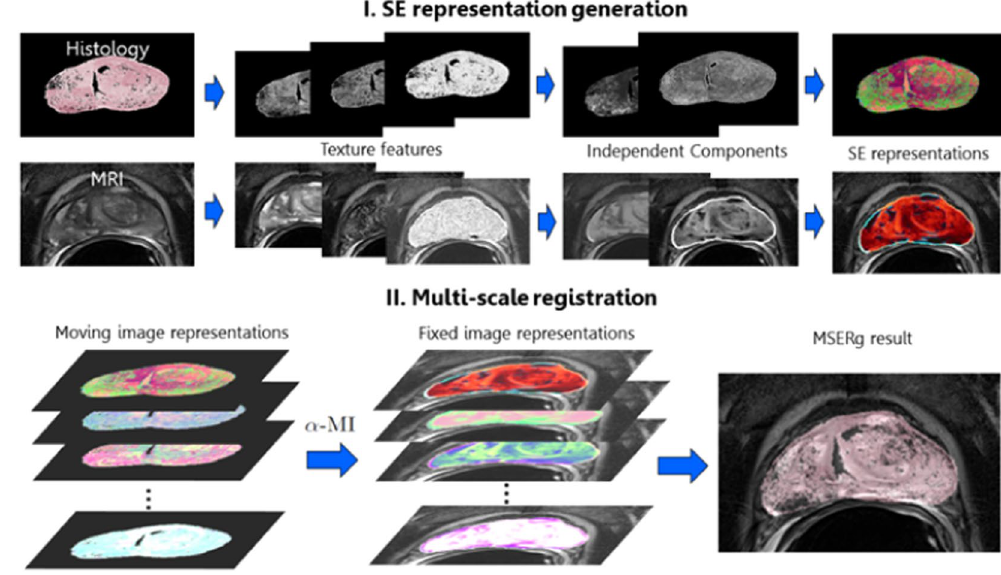
Figure 2. MSERg comprises 2 main modules: Firstly a SE representation is constructed at each scale. (1) Texture feature extraction is performed at each length scale within both the fixed and moving images. (2) ICA is then performed at each texture feature length scale, and (3) spectrally embed the ICs extracted from the texture features at each length scale. The second module involves multi-scale registration. This module comprises the following main steps. (1) Identifying and combining image representations at optimal length scales in order to drive co-registration and (2) using α -MI to combine the scale spaces of spectral embedding vectors in order to facilitate radiology-pathology